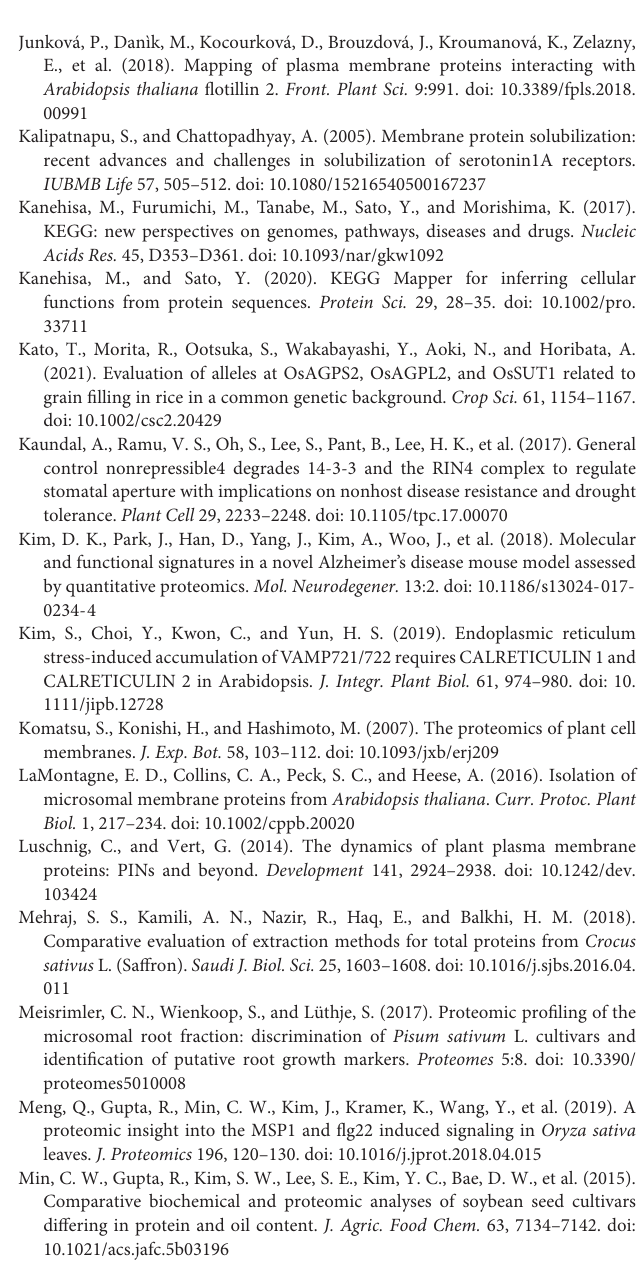
Supplementary Table 7 | GO enrichment analysis of differentially modulated proteins by comparison between the samples dissolved in two different surfactants. different surfactants. KEGG brite